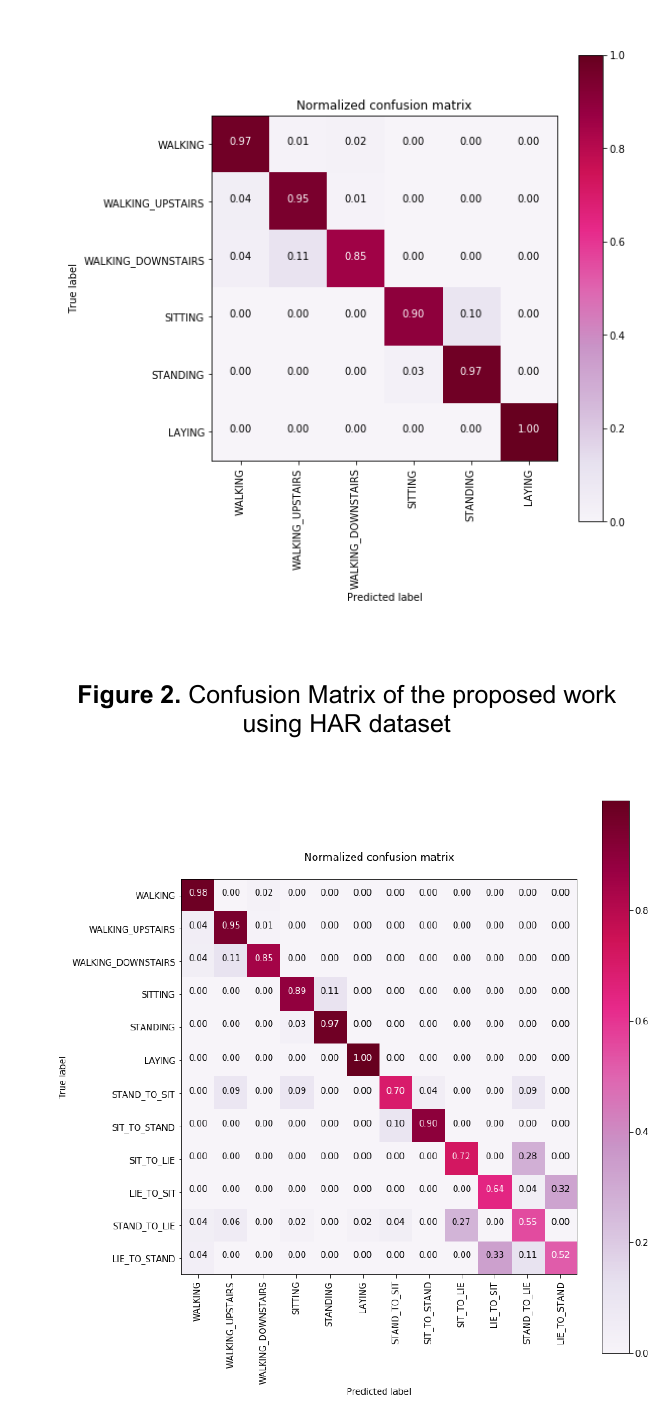
Figure 3. Confusion Matrix of the proposed work using HAPT